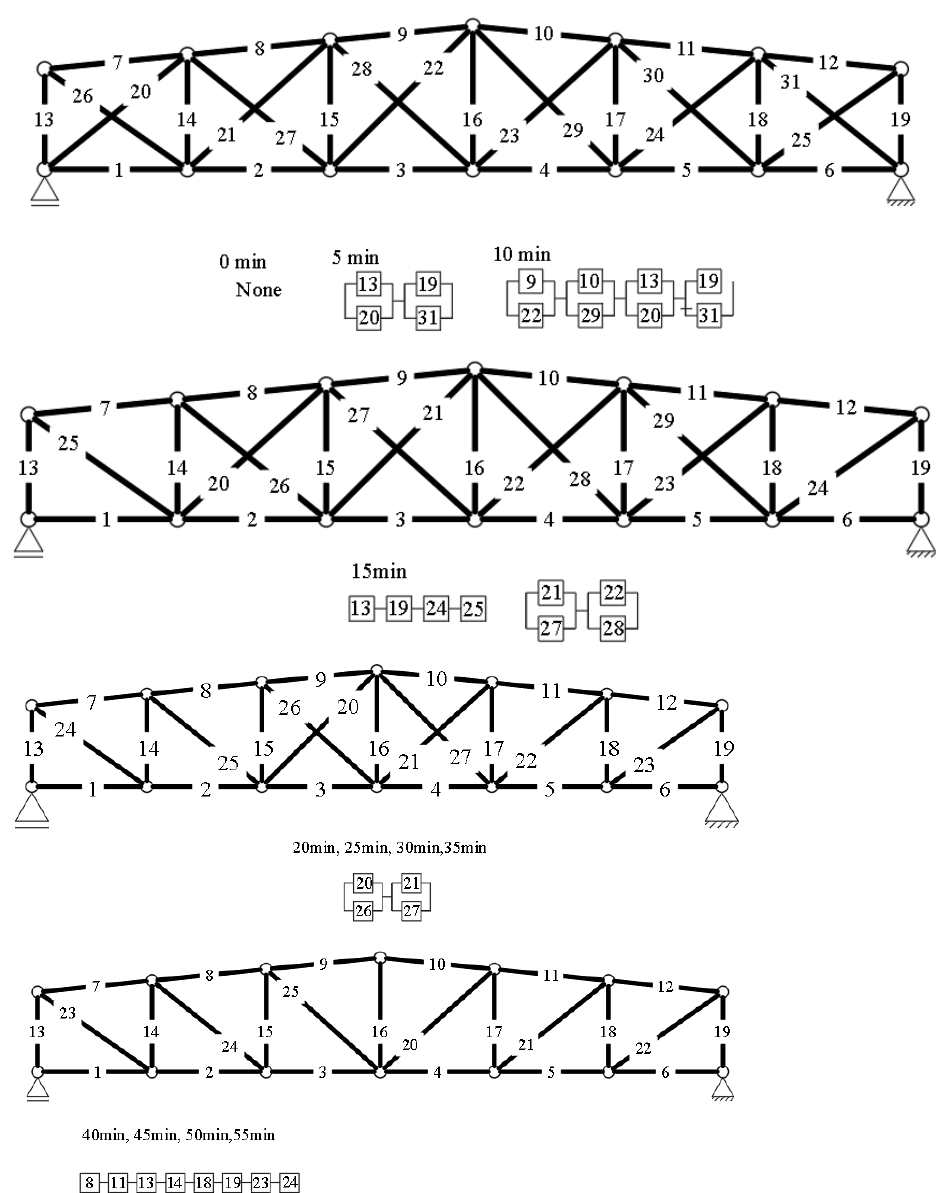
Figure 7. Static schemes of Truss 1 in subsequent minutes of fire duration and corresponding cut-sets.